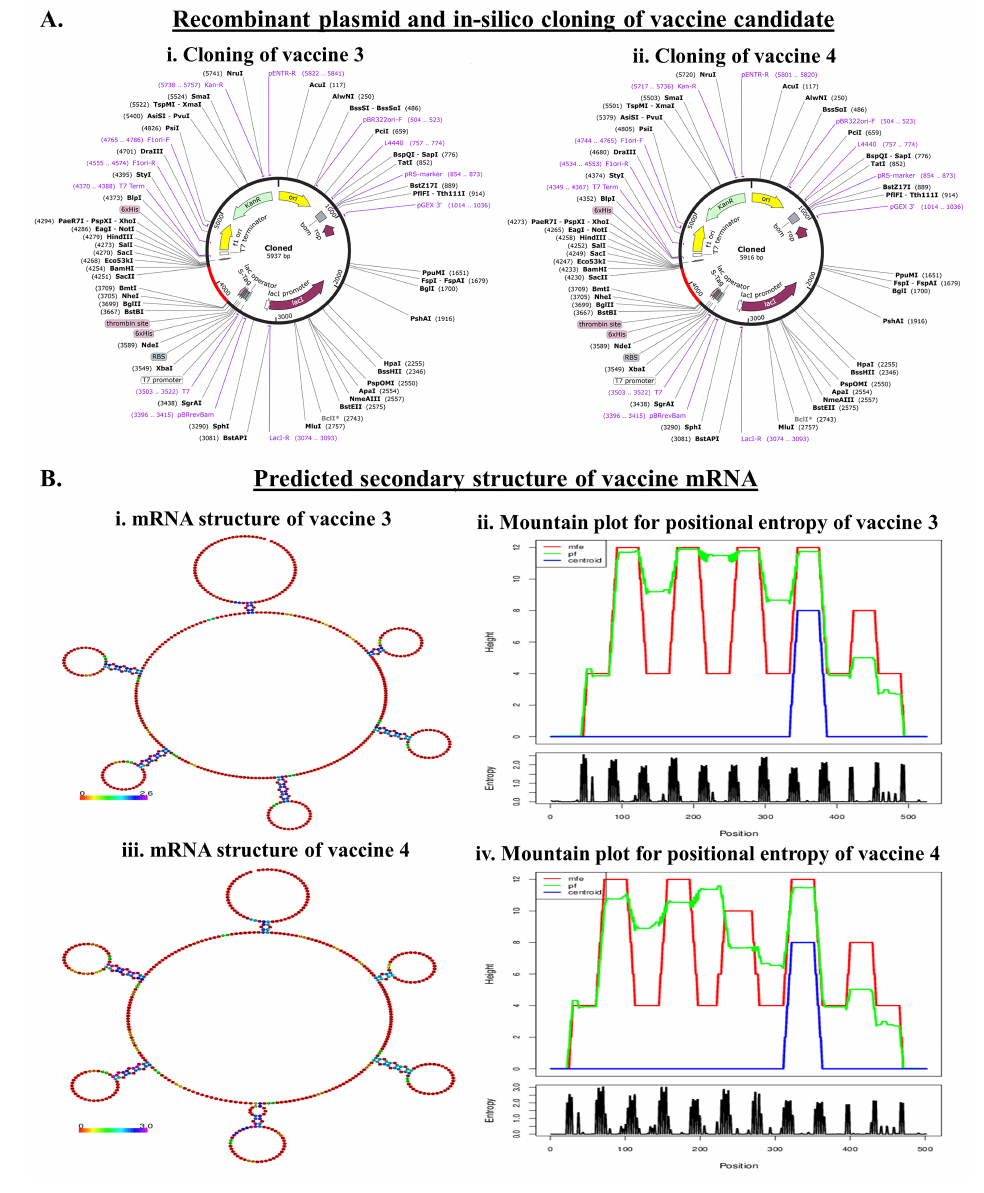
Figure 6. In silico cloning of the gene sequence of the vaccines in pET30ax vector and the predicted secondary mRNA structures. ( A ). Recombinant plasmid and in silico cloning of ( i ). VACCINE 3, ( ii ). VACCINE 4. The vaccine region is represented by red color. ( B ). Predicted secondary structure of vaccine mRNA ( i ). Minimum free energy (MFE) structure and ( ii ). Mountain plot exhibiting the comparative relation between the MFE, the thermodynamic ensemble, and the centroid structure of the mRNA of VACCINE 3. ( iii ). Minimum free energy (MFE) structure and ( iv ). Mountain plot exhibiting the comparative relation between the MFE, the thermodynamic ensemble, and the centroid structure of the mRNA of the VACCINE 4. Positional entropies are also reflected in the plot where the plateaus and slopes respectively dignify the loops and